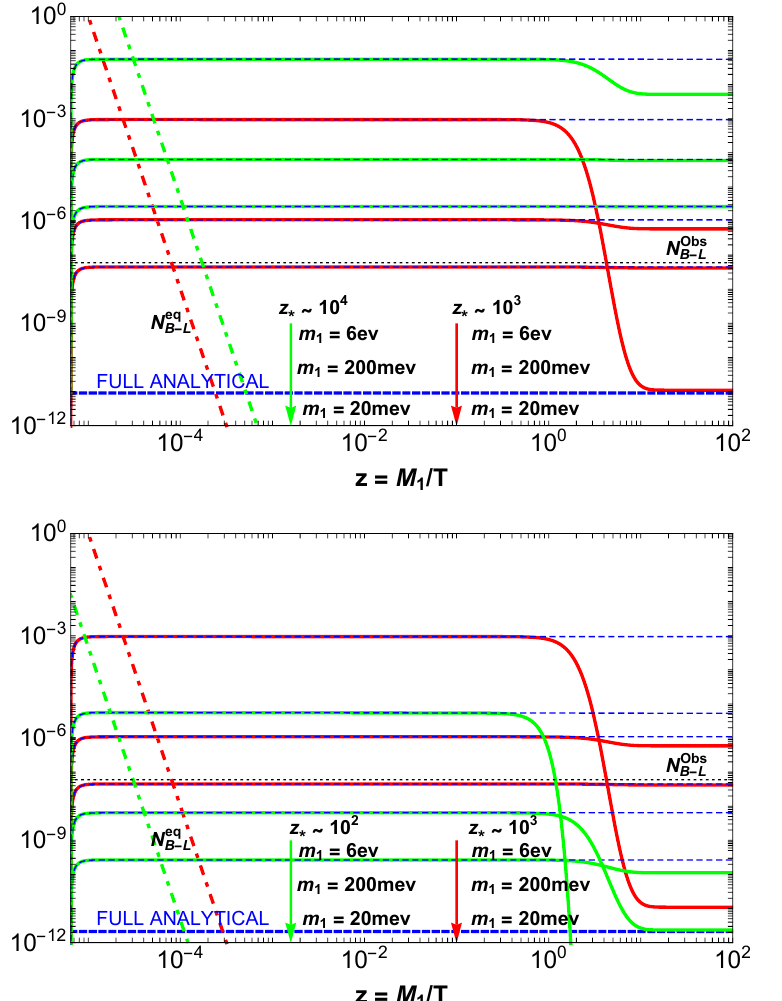
Figure 4 . Top: EOS: ω = 1 . Evolution of the gravitationally produced asymmetry for different values of m 1 . We have taken M 1 = 10 8 GeV, z ∗ = 1 . 3 × 10 3 (red), 10 4 (green) as benchmark values. Bottom: EOS: ω = 1 . Evolution of the gravitationally produced asymmetry for different values of m 1 . We have taken M 1 = 10 8 GeV, z ∗ = 1 . 3 × 10 3 (red), 10 2 (green) as benchmark values. For both the plots we use M 3 = 10 14 GeV, M 2 = 10 12 GeV, x ij = π/ 4 , y ij = 10 − 4 , q ∆ m 2 = 7 . 4 × 10 − 5 eV 2 , ∆ m 2 = 2 . 4 × 10 − 3 eV 2 and z in = M 1 / ˜ M pl . The thick blue dashed line 12 32 shows a match bewteen numerical solutions and the master equation obtained in eq. (B.20). The thin blue dashed lines show a match bewteen numerical solutions and solution obtained (without the late time N 1 -washout) in eq.